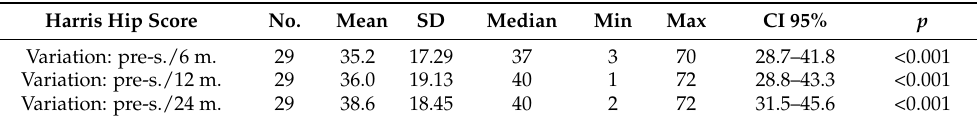
Table 3. Mean HHS values of all revisions in the different follow-up intervals and their comparison with the pre-surgical mean